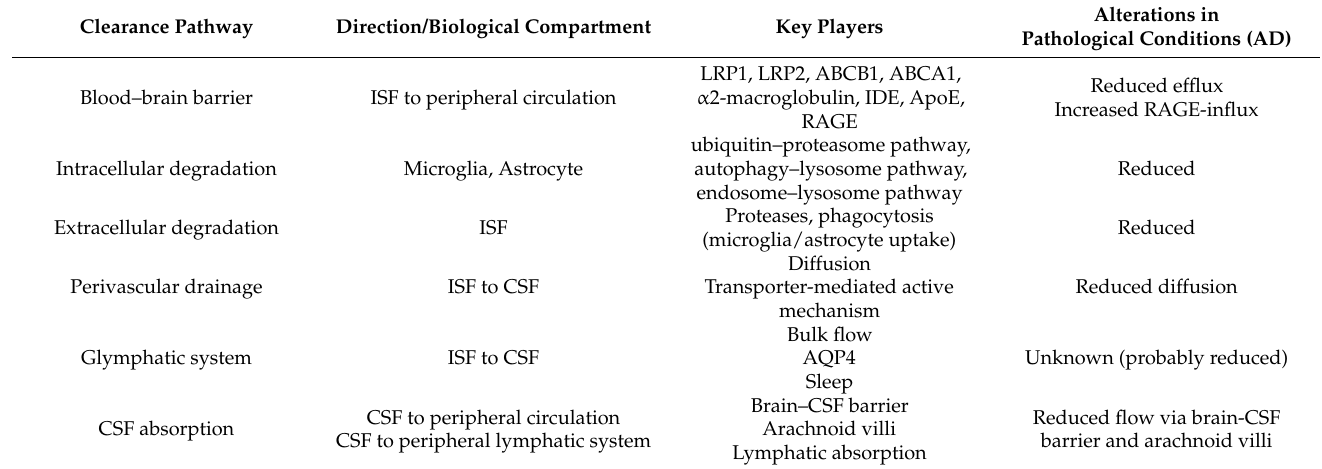
Table 1. A β clearance pathways from